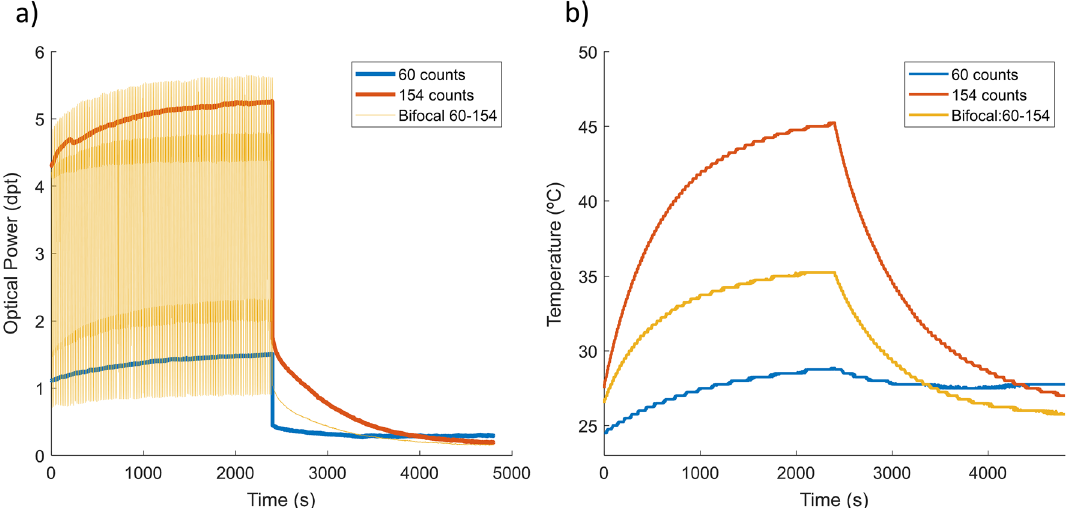
Figure 7. Dynamic experiment description. ( a ) Optical power profile of a static state of 154 counts (red), a low static state of 60 counts (blue) and a bifocal driving signal (yellow) comprising both states. ( b ) Lens internal temperature profile for each